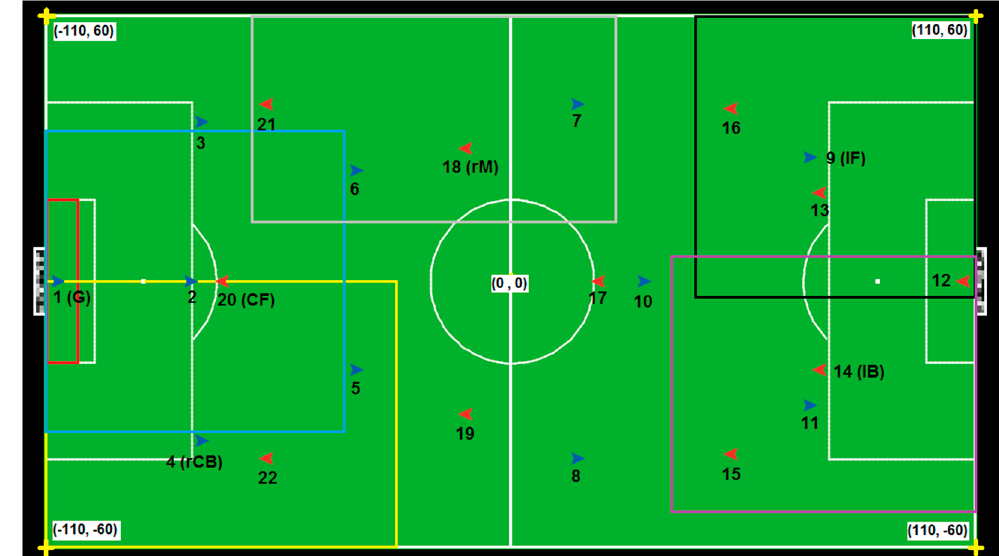
Figure 5. Autonomous agents (players) and environmental actors (player role-boxes, pitch, goals, ball) in the football simulation (zero-order capabilities not shown).